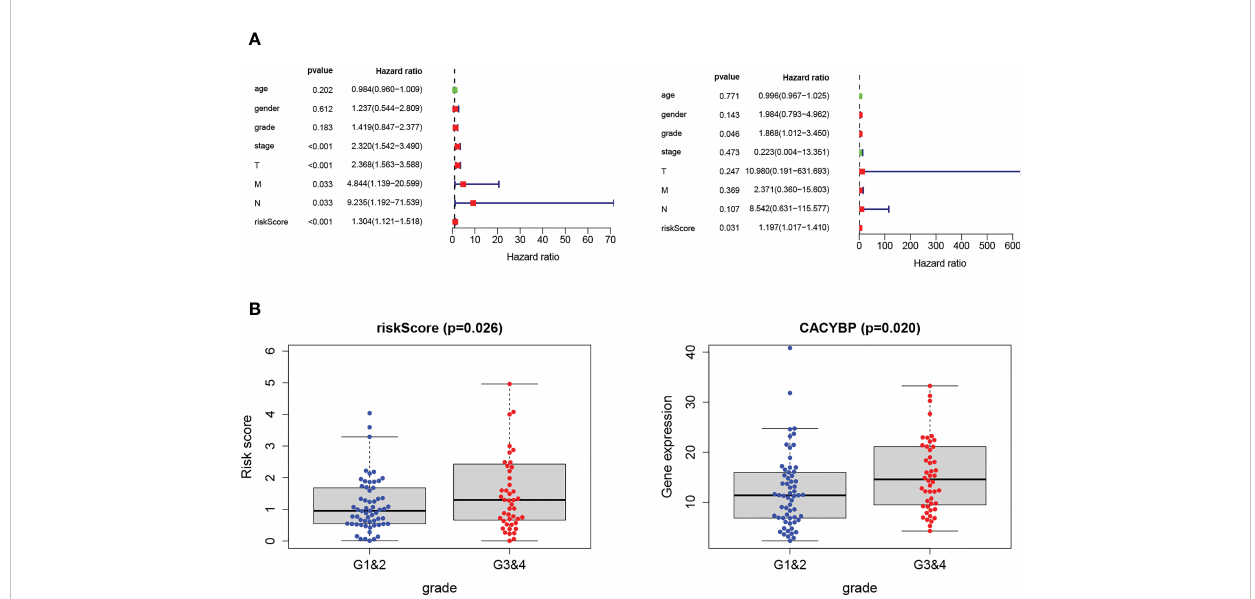
FIGURE 8 Validation of Tex-related HCC prognostic model in independent ICGC cohort. (A) Univariate and multivariate analyses indicated that the Grade and the risk score were independent prognostic factors of HCC patients. (B) The risk score and CACYBP had a signi fi cant correlation with Grade classi fi cation. *** indicates signi fi cant difference at p < 0.001.